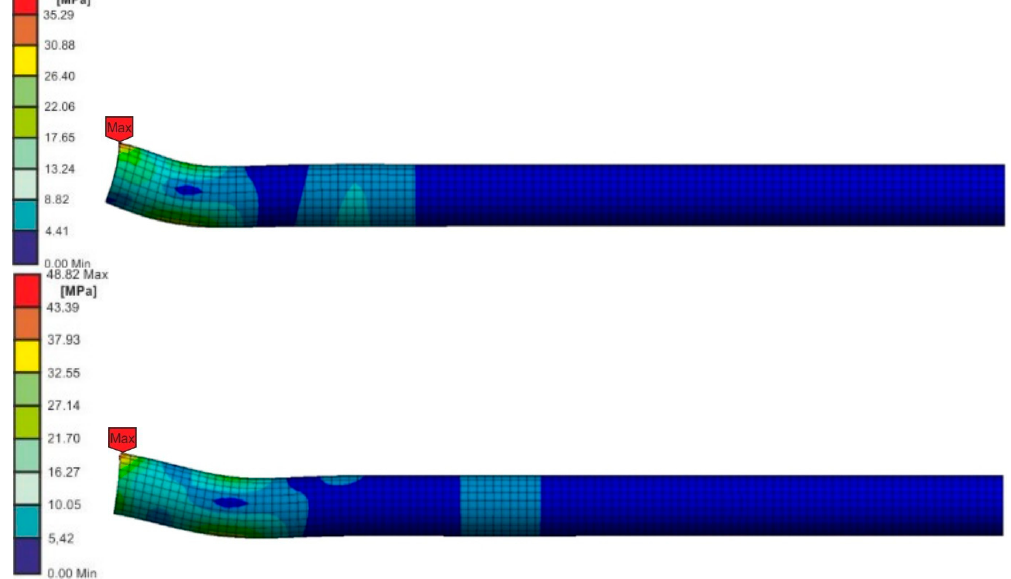
Figure 11. Von Mises stress distribution in the pendulum arm, loaded with the energy of 3 J at the speeds 3.81 m/s (upper picture) and 2.42 m/s (bottom picture) at stress in joint close to the adhesive strength.